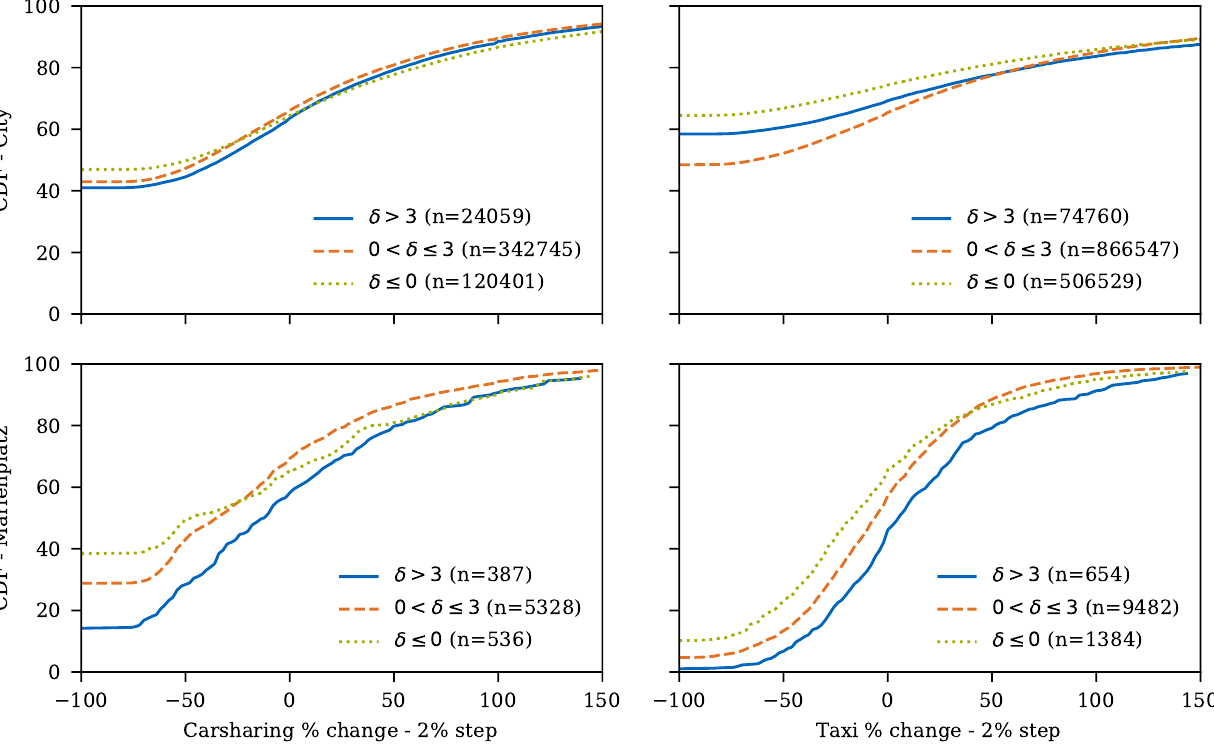
Figure 8. Maximum Delay in the Entire City and at